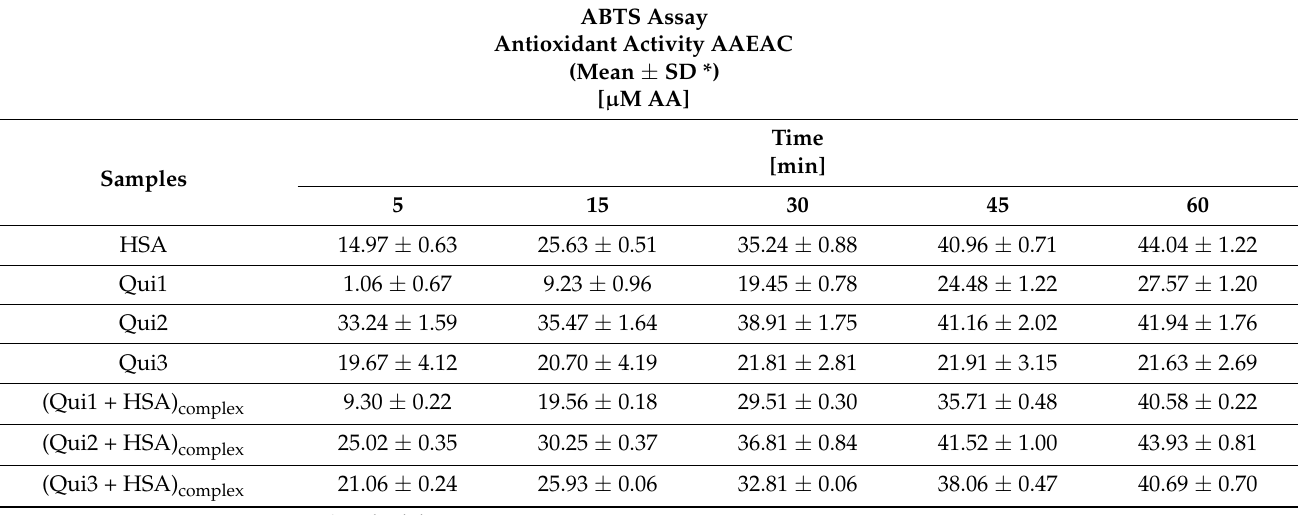
Table 8. The Total Antioxidant Capacity (AAEAC); ([Qui1] = [Qui2] = [Qui3] = 8 × 10 − 6 M),